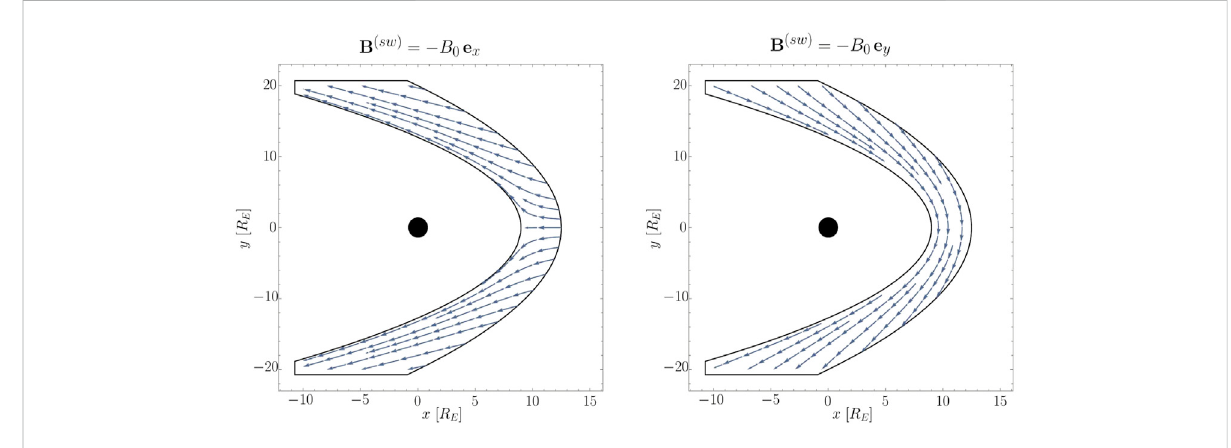
FIGURE 1 Field lines in the magnetosheath in the x - y plane for the case of B (sw) = − B 0 e x as well as B (sw) = − B 0 e y